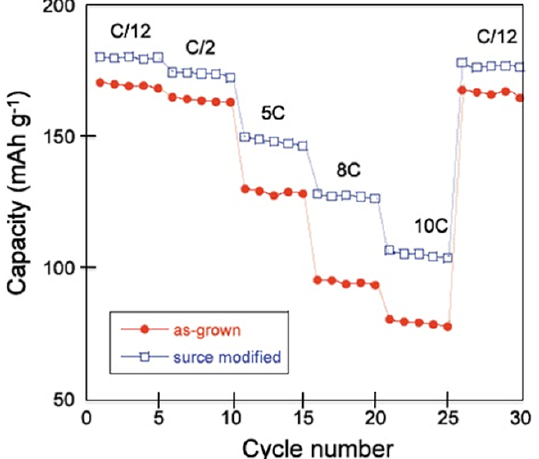
Figure 3. The modified Peukert plots of Li cells for the as-grown and the surface modified LNMC cathode material. (Reprinted with permission from [57]. Copyright 2011